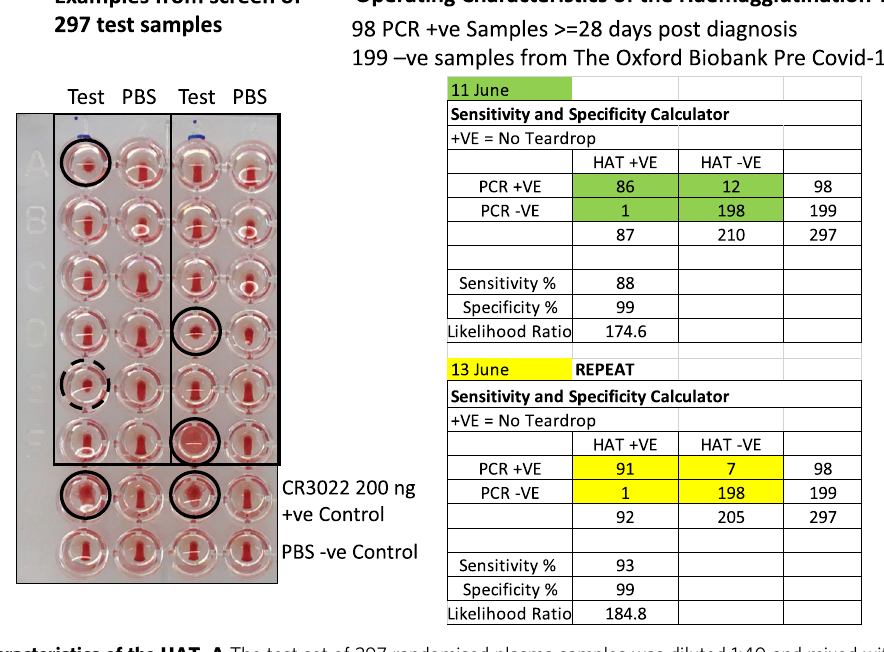
Fig. 4 Operating characteristics of the HAT. A The test set of 297 randomised plasma samples was diluted 1:40 and mixed with 1:40 O − ve blood in two columns. IH4-RBD (100 ng in 50 µ L) was added to the test samples and PBS to negative control wells. The plates were incubated at room temperature for 1 h to allow the red cell pellet to form, then tilted for ~30 s to allow a teardrop to form. Complete loss of teardrop was scored as positive agglutination (marked with a black solid-line circle). Full teardrop or partial teardrop (marked with a dotted-line circle) was scored negative. The samples in columns were re-randomised and tested a second time 2 days later. B Contingency table showing the operating characteristics of the HAT. Source data are provided as a Source Data fi